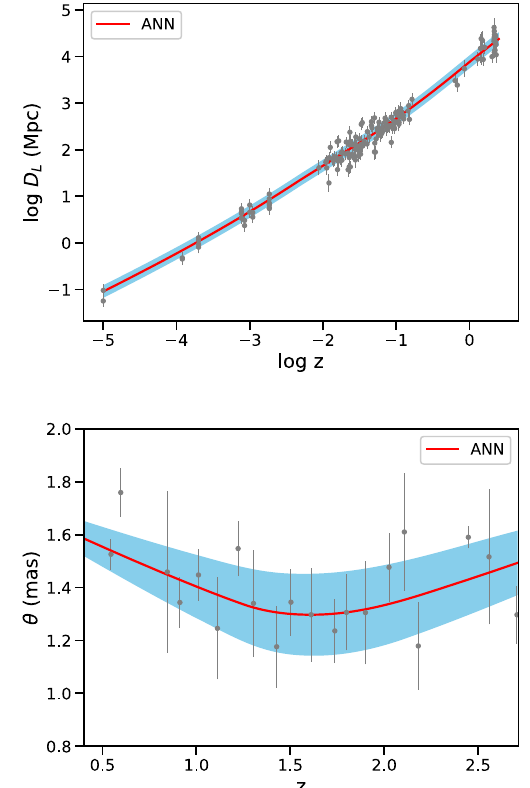
Fig. 2 Top panel: The reconstructed function log D L , HII ( z ) with 1 σ errors by using ANN (red line), and the gray dots with error bars rep- resent measurements of HII regions; Bottom panel: The reconstructed function θ( z ) by using ANN from compact radio sources